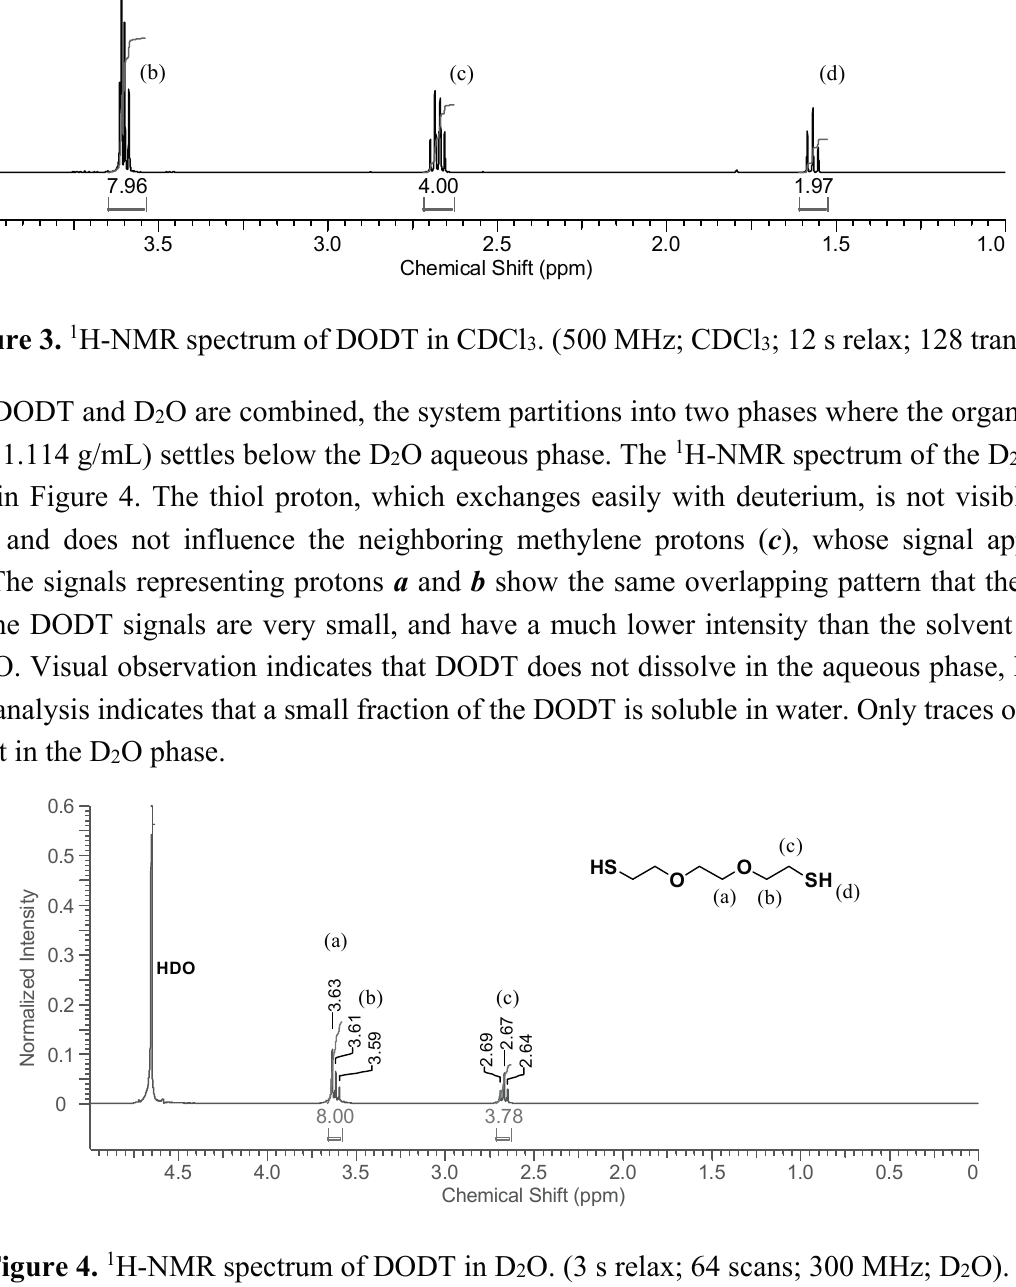
Figure 4. 1 H-NMR spectrum of DODT in D 2 O. (3 s relax; 64 scans; 300 MHz; D 2